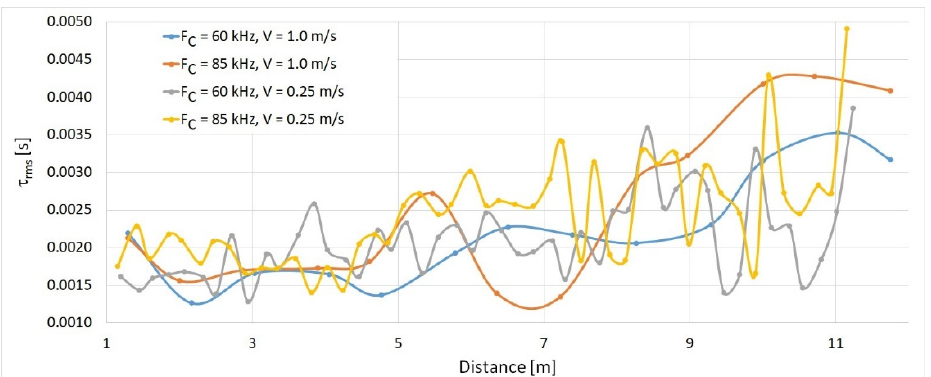
Figure 14. Influence of the distance from the receiver on the delay spread for chirps with a center frequency of F C = 60 kHz, a bandwidth of B = 10 kHz, and different durations, T , for the transmitter velocities of V = 1 m/s and V = 0.25 m/s.